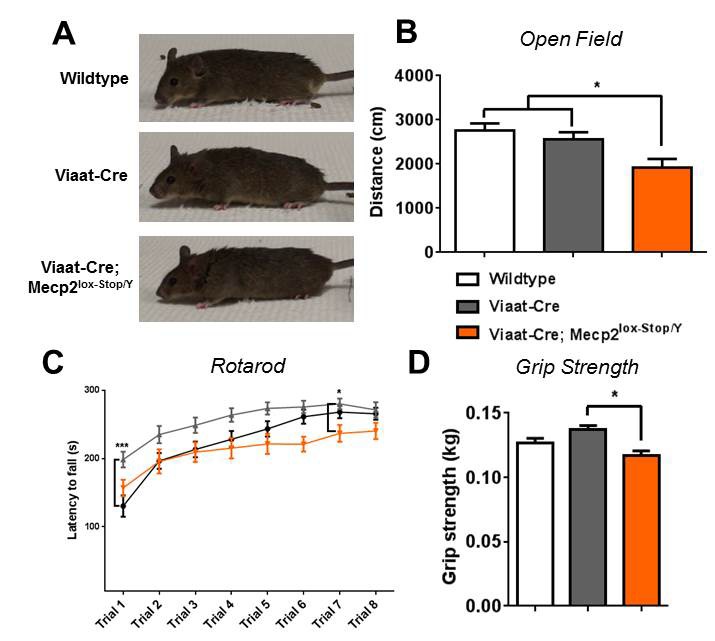
Rescue persisted in male mice at 30 weeks of age.(A) Male rescue mice at 30 weeks of age continued to appear indistinguishable from wildtype and Viaat-Cre littermates. (B) Locomotion in the open field assay decreased when compared to wildtype but not Viaat-Cre. (C–D) Rotarod performance was maintained at wildtype levels, as was grip strength (D). n = 20–25 per genotype. Error bars show SEM. *p<0.05DOI: